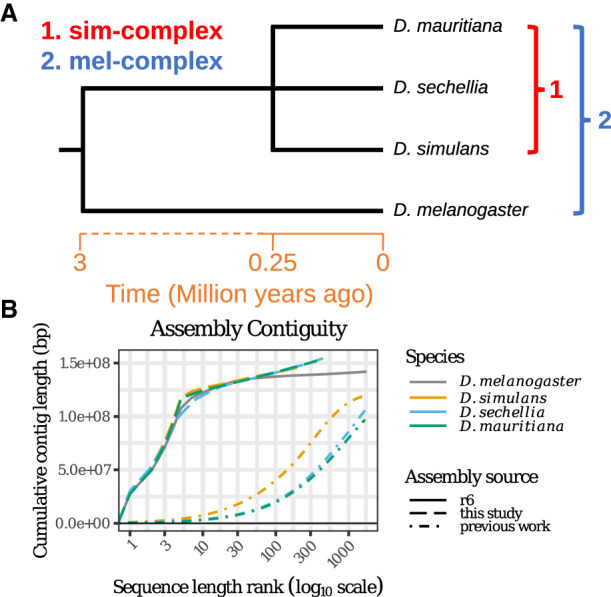
Reference-quality de novo genome assemblies of the Drosophila melanogaster species complex. (A) Phylogeny showing the evolutionary relationship among the members of four mel-complex species. (B) Contiguities of the new assemblies from the sim-complex and the reference assembly of D. melanogaster (R6). The contigs were ranked by their lengths, and their cumulative lengths were plotted on the y-axis. The colors represent different species. The D. melanogaster genome is the release 6 assembly (Hoskins et al. 2015). For previous work, Drosophila simulans is ASM75419v3 (Hu et al. 2013), Drosophila sechellia (r1.3) is from Drosophila 12 Genomes Consortium (2007), and Drosophila mauritiana is from Garrigan et al. (2014).